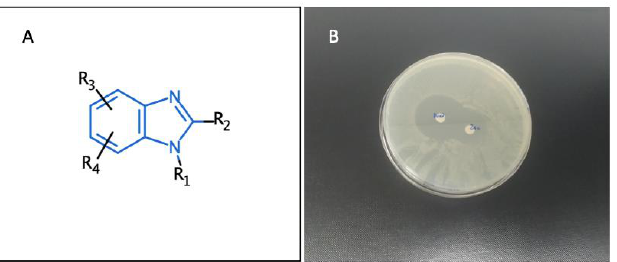
Figure 19. ( A ) Benzimidazole general structure; ( B ) synergistic effect of a derivative synthesized in this work and tested against E. coli through disk diffusion assay.